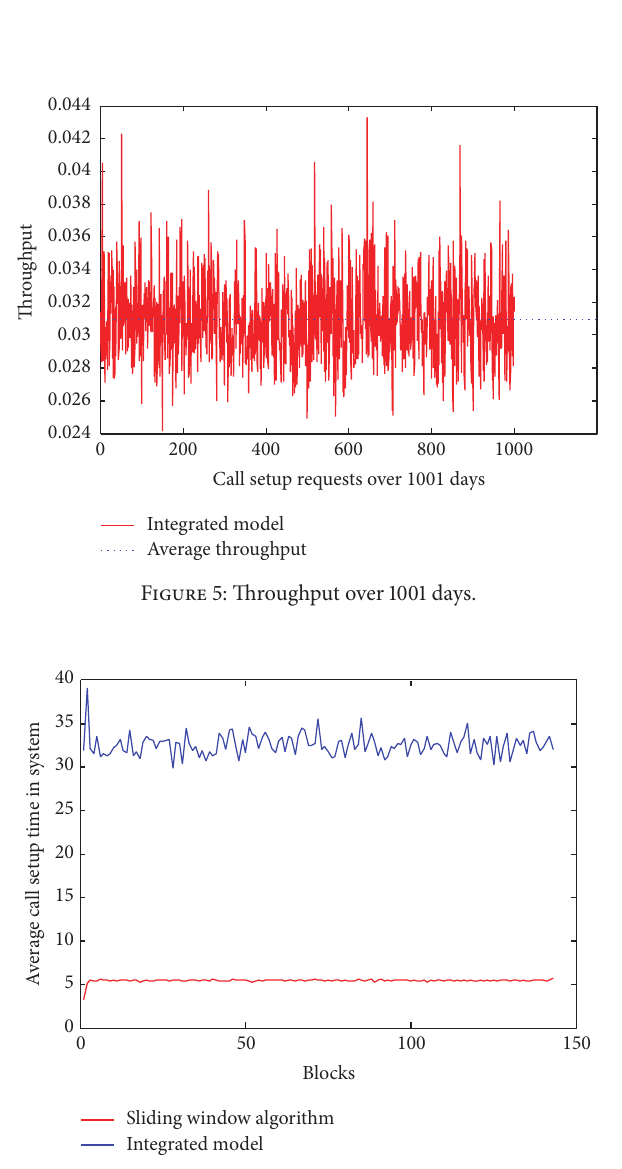
Figure 6: Call setup time in system versus blocks at a MSC.